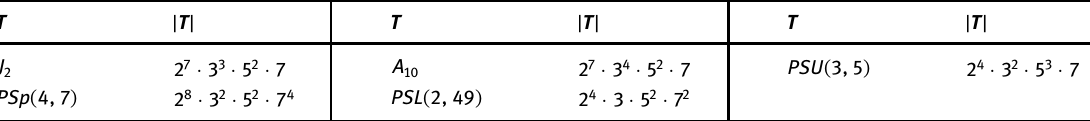
Table 4: The simple K 4 - groups in Lemma